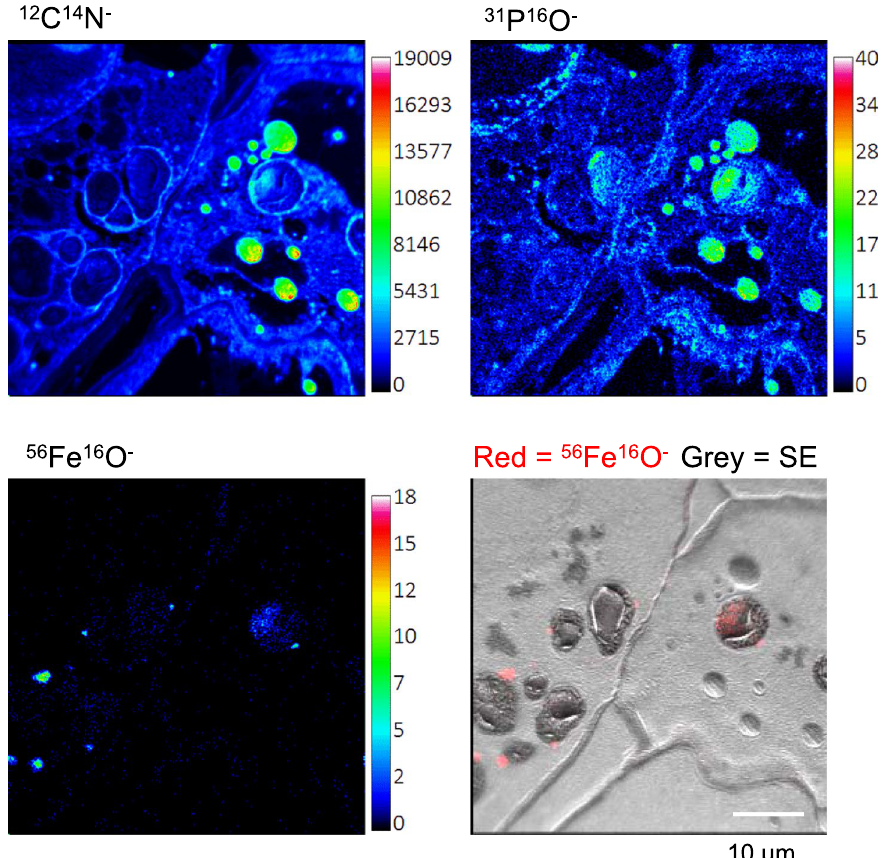
Figure 5. Colocalization of Fe with protein and PO compounds. NanoSIMS images of 12 C 14 N (top left), 31 P 16 O − (top right), and 56 Fe 16 O − (bottom two images) in cotyledons of immature pea seeds (JI1194) at 22–24 DAF. The images show part of neighbouring cells representative of the cotyledons. The image bottom left shows the dense iron spots on the outside of amyloplasts as well as the diffuse pattern of iron inside the amyloplasts (overlay of 56 Fe 16 O − in red and secondary electrons, SE, in grey scale). The images are representative of 4 different regions each showing colocalization of Fe with PO